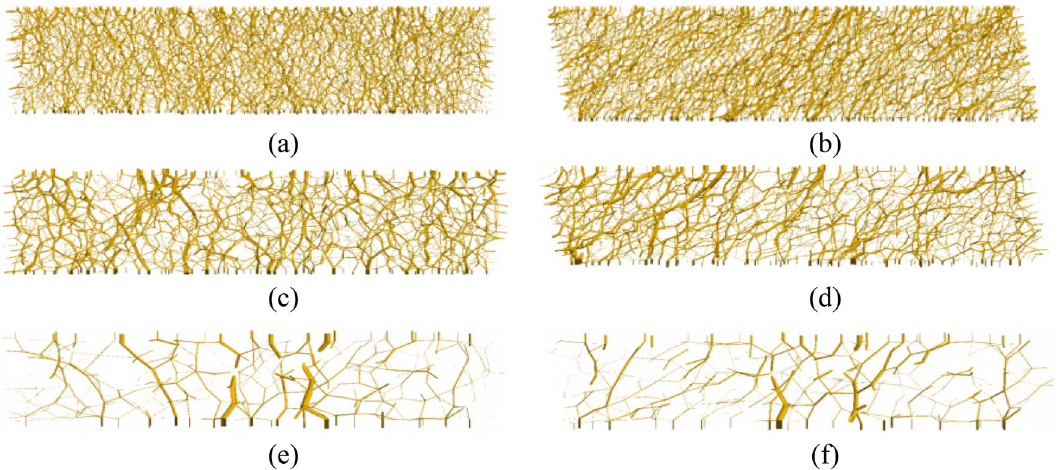
Figure 6. Contact force networks: ( a ) 1D after consolidation, (b) 1D 20% shear strain, ( c ) 2D after consolidation, ( d ) 2D 20% shear strain, ( e ) 4D after consolidation, ( f ) 4D 20% shear strain.